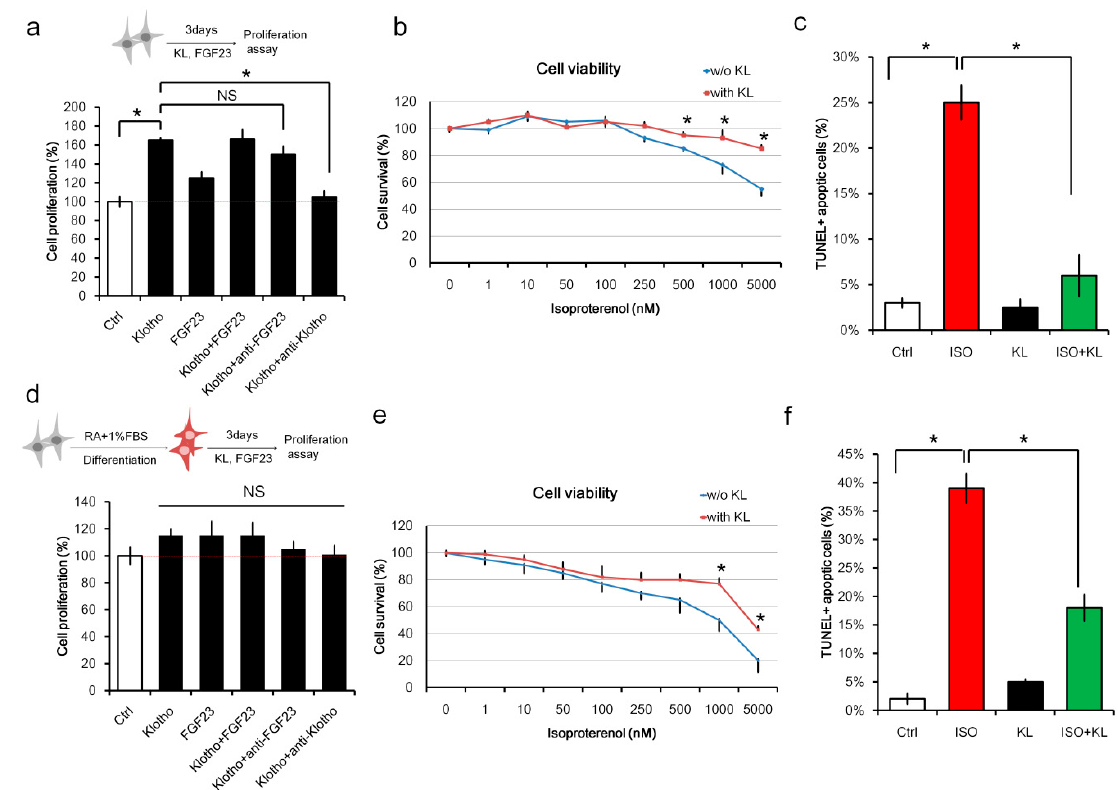
Figure 1. KL ( α -klotho) attenuated isoproterenol-induced cell death in H9C2 cardiomyocytes. ( a ) Un- differentiated H9c2 cells were cultured with KL (200 ng/mL), fibroblast growth factor-23 (FGF23) (100 ng/mL), KL (200 ng/mL) plus FGF23 (100 ng/mL), KL (200 ng/mL) + anti-FGF23 (1 μ g/mL), or KL (200